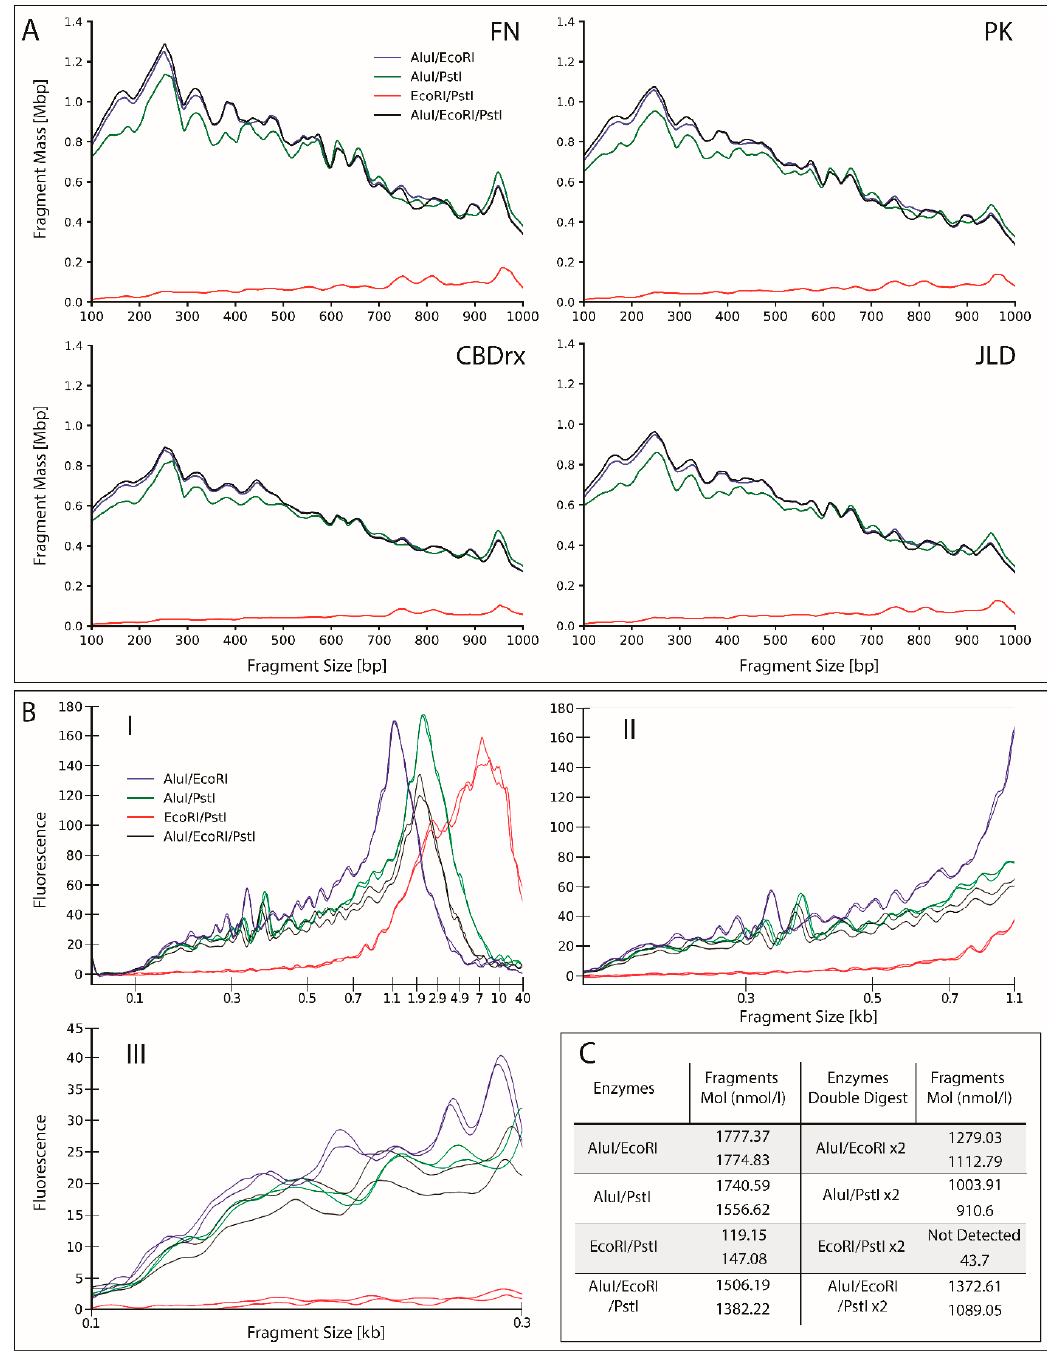
Figure 2. Digestion of Cannabis assemblies and Swiss Dream Auto genomic DNA. ( A ) Four Cannabis assemblies, Finola (FN), Purple Kush (PK), CBDrx (CBD), and Jamaican Lion DASH (JLD), were digested in silico with four restriction endonuclease combinations, including the AluI/EcoRI, AluI/PstI, EcoRI/PstI, and AluI/EcoRI/PstI combinations. ( B ) Cannabis genomic DNA was digested with the same four restriction endonuclease combinations and the fragmentation profiles were assessed; ( I ) up to 40 kb; ( II ) between 100 and 1000 bp and; ( III ) between 100 and 300 bp on a LabChip Bioanalyzer to determine the optimum combination. ( C ) Smear analysis was performed to compare single (left panel) and double (right panel) digestion reactions in replicate to determine the degree of ‘completeness’ of each restriction endonuclease